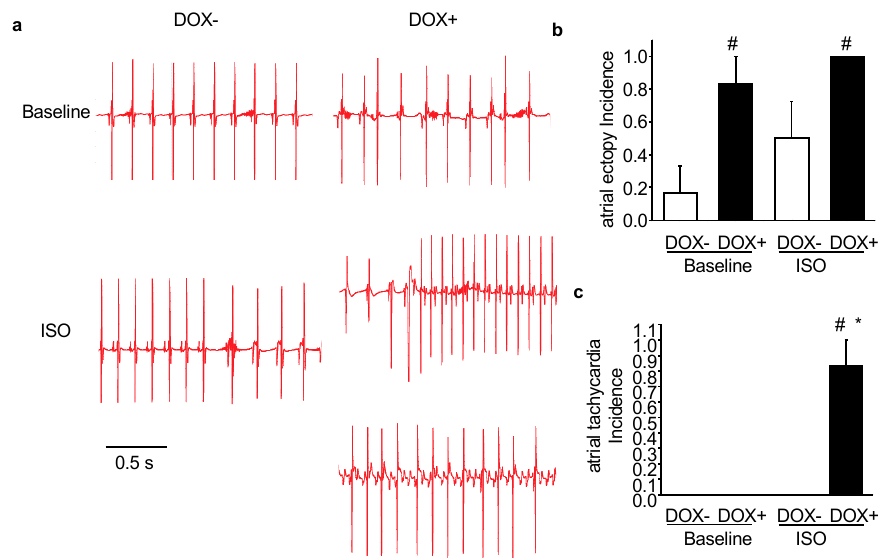
Figure 3. Acute SERCA2a overexpression exacerbated atrial arrhythmias in a CPVT mouse model of CASQ2 KO. ( a ) representative ECG traces for the KO-TG mice before (DOX-) and after the induction of SERCA2a overexpression (DOX + ) under baseline condition or with injection of ISO; ( b ) the incidence of developing atrial ectopy; ( c ) the incidence of developing atrial tachycardia. * p < 0.05 vs. WT control; # p < 0.05 vs. DOX − .